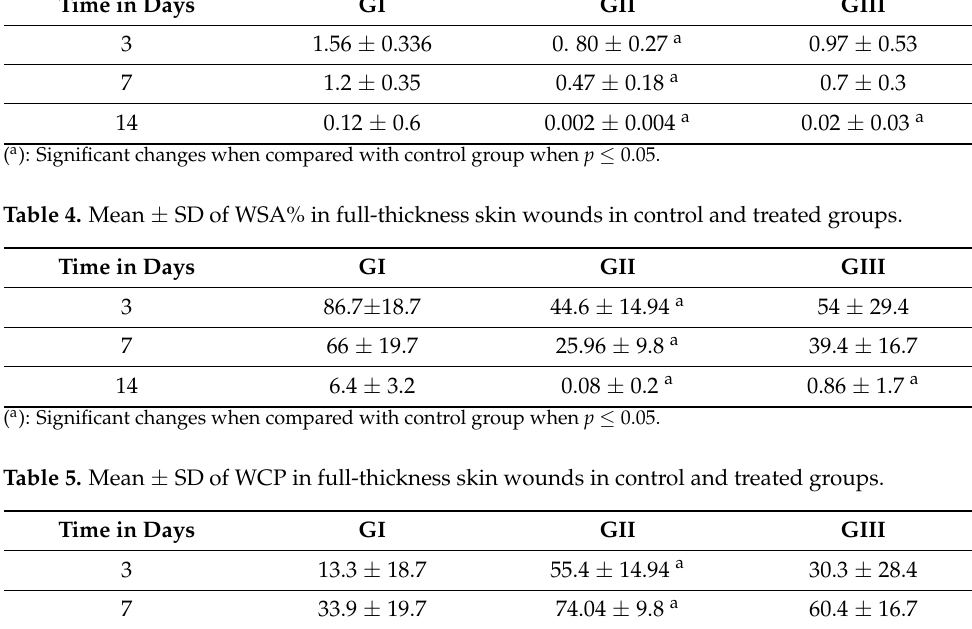
Table 3. Mean + SD of WSA in full-thickness skin wounds in control and treated groups. Time in Days GI GII GIII 3 1.56 ± 0.336